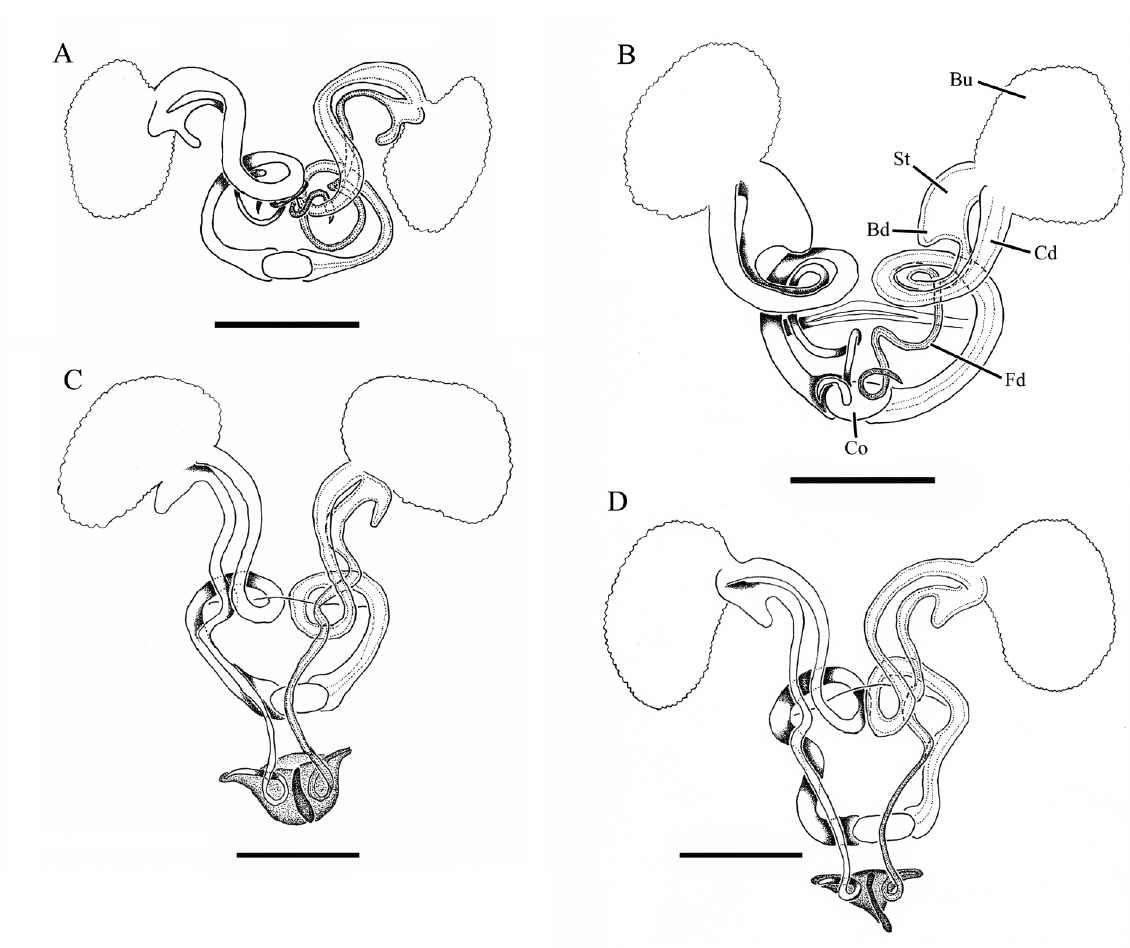
Fig. 9. Vulvae of Uroctea grossa Roewer, 1960; dorsal view. A . ♀ from Mazandaran Province, Larijan (MHNG). B . Holotype, ♀ (GNM-A497). C . ♀ from Turkmenistan (SMF38817). D . ♀ from Sistan and Baluchistan Province, surroundings of Taftan volcano (MHNG). Scale bars = 0.5